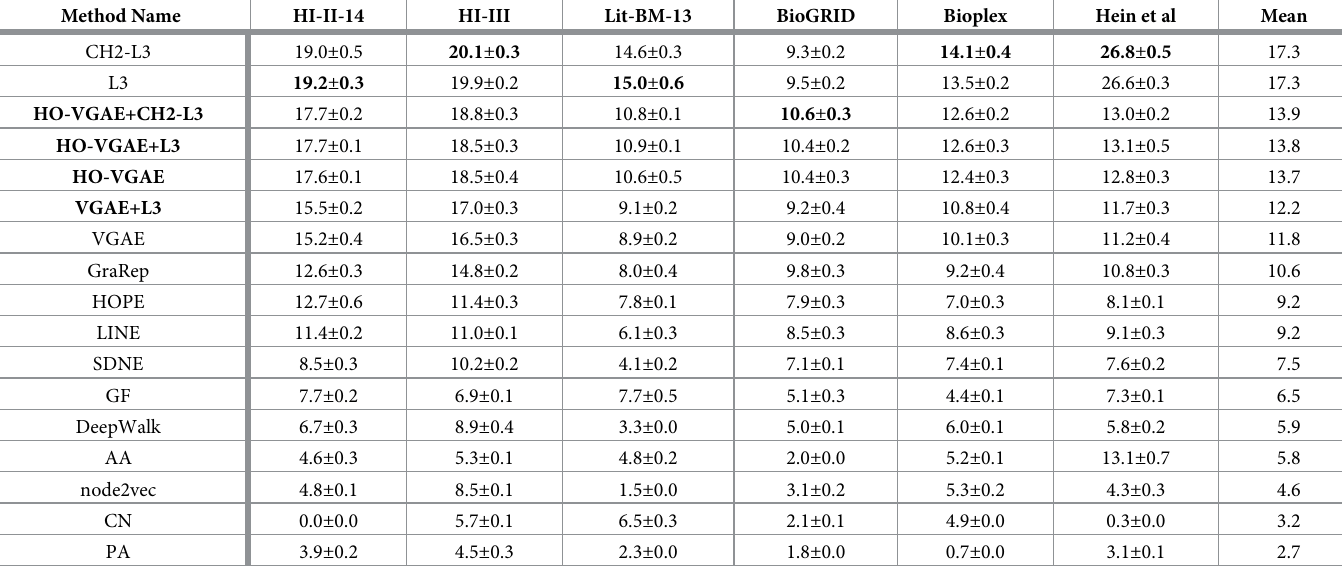
Table 2. Overall link prediction performance comparison on six human PPI networks (Precision@k). Method